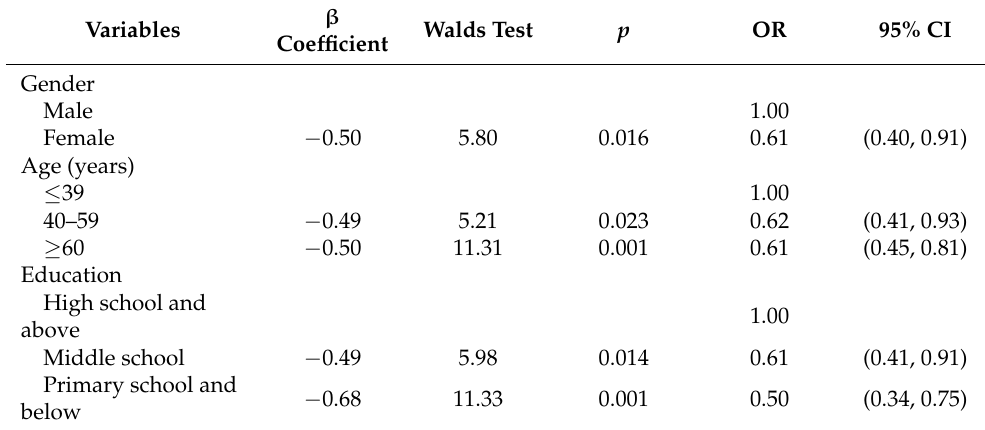
Table 6. Results of binary logistic regression analysis of risk factors for low